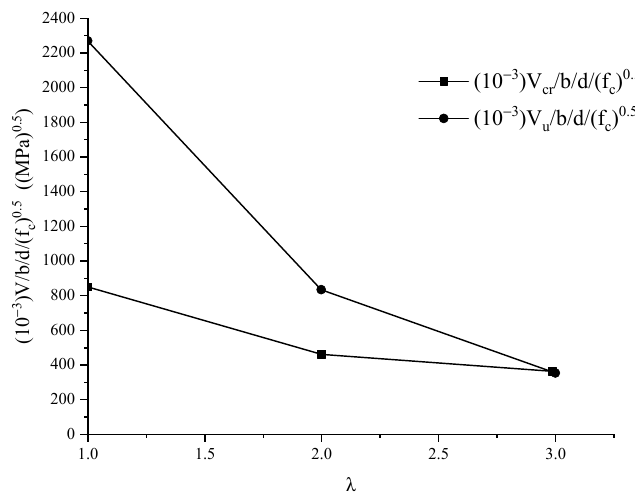
Figure 14. Effect of λ on normalized V cr and V u .